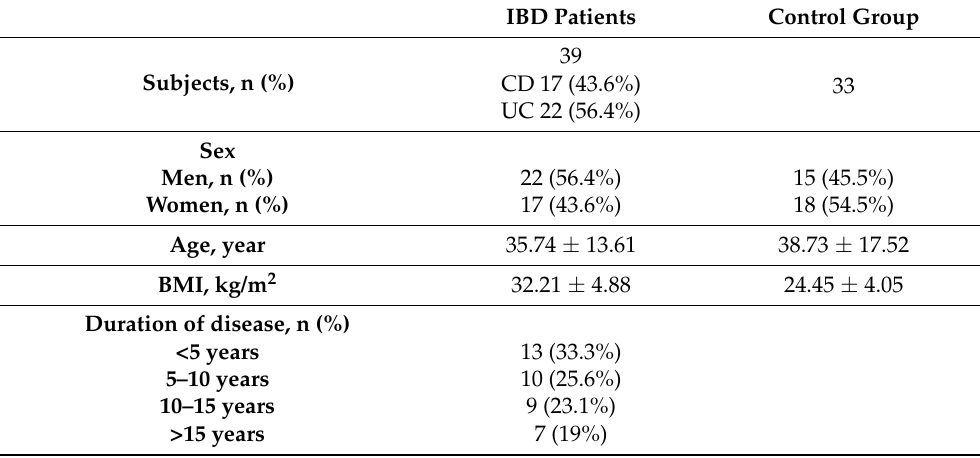
Table 1. Socio-demographic and clinical data of inflammatory bowel disease (IBD) patients and healthy